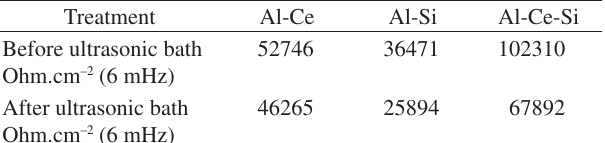
Table 2. Real impedance at 6 mHz for AA 2024-T3 coated according to the different procedures prior and after the sonication test. Immersion time 72 hours.